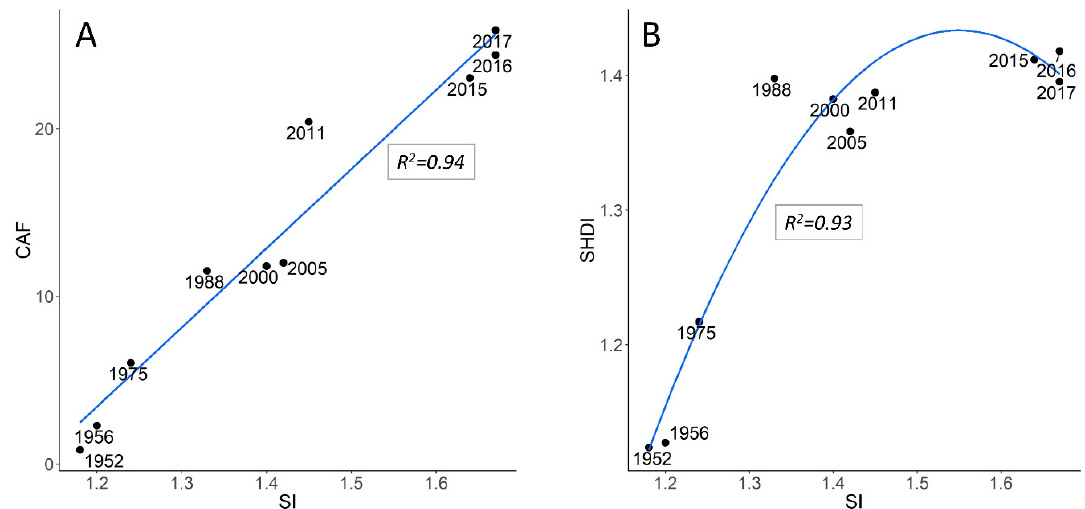
Figure 9. Sinuosity as independent factor of land cover changes and landscape diversity in the study area. ( A ) The relationship between the SI (Sinuosity Index) and CAF (Class area of Forests); ( B ) Relationship between the SI (Sinuosity Index) and SHDI (Shannon’s Diversity Index) metrics.